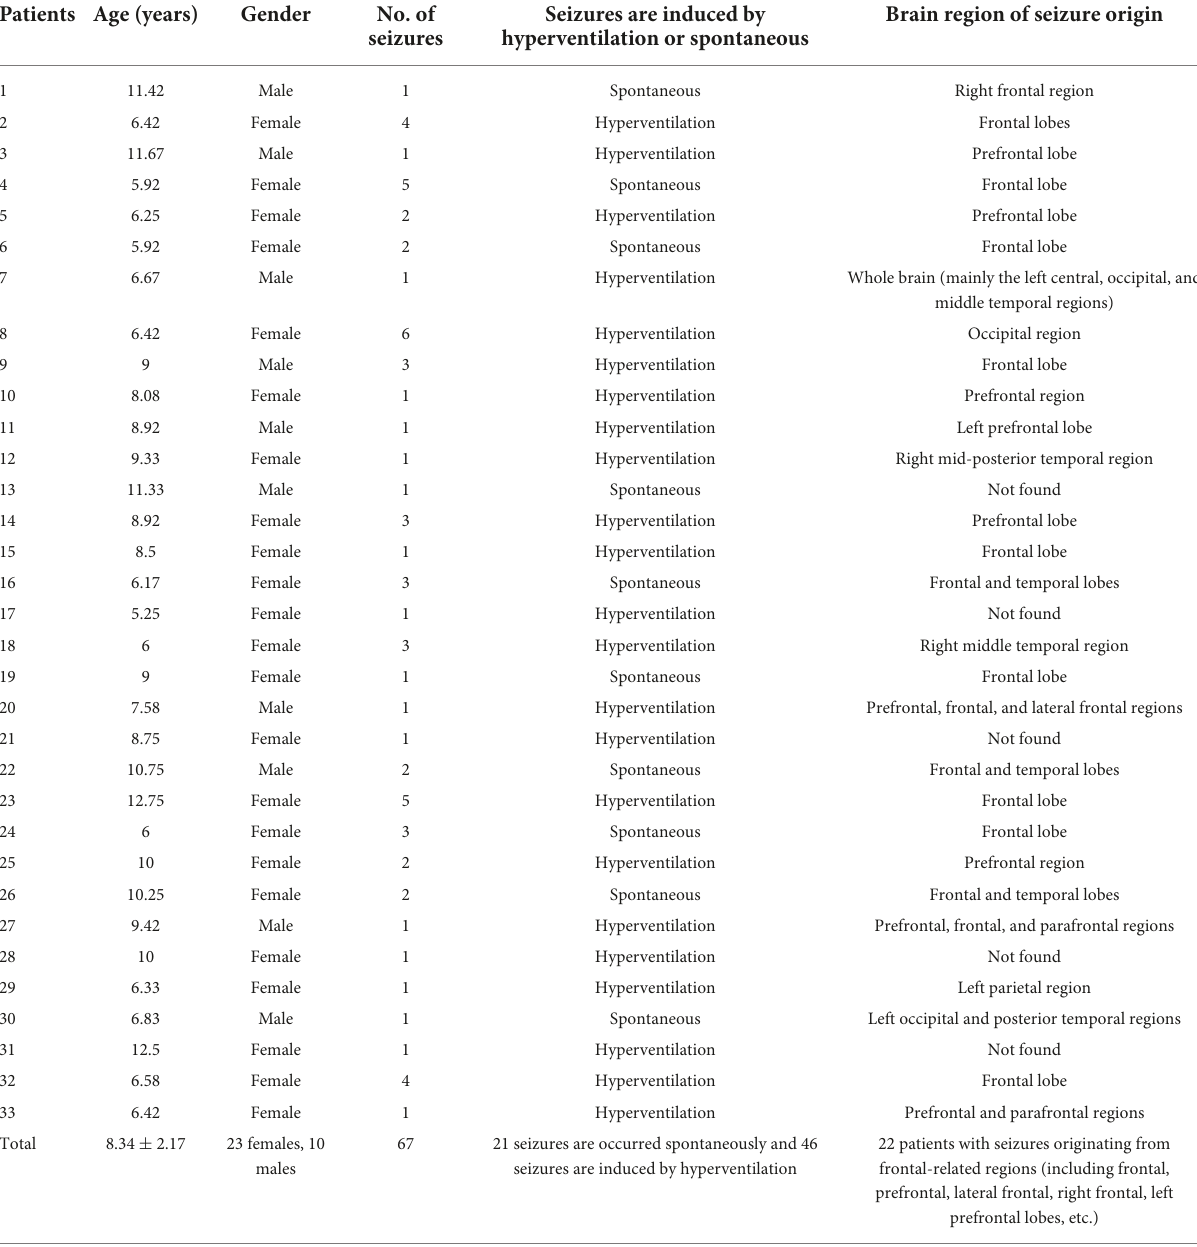
TABLE 1 Detailed information of the clinical CAE patients. Patients Age